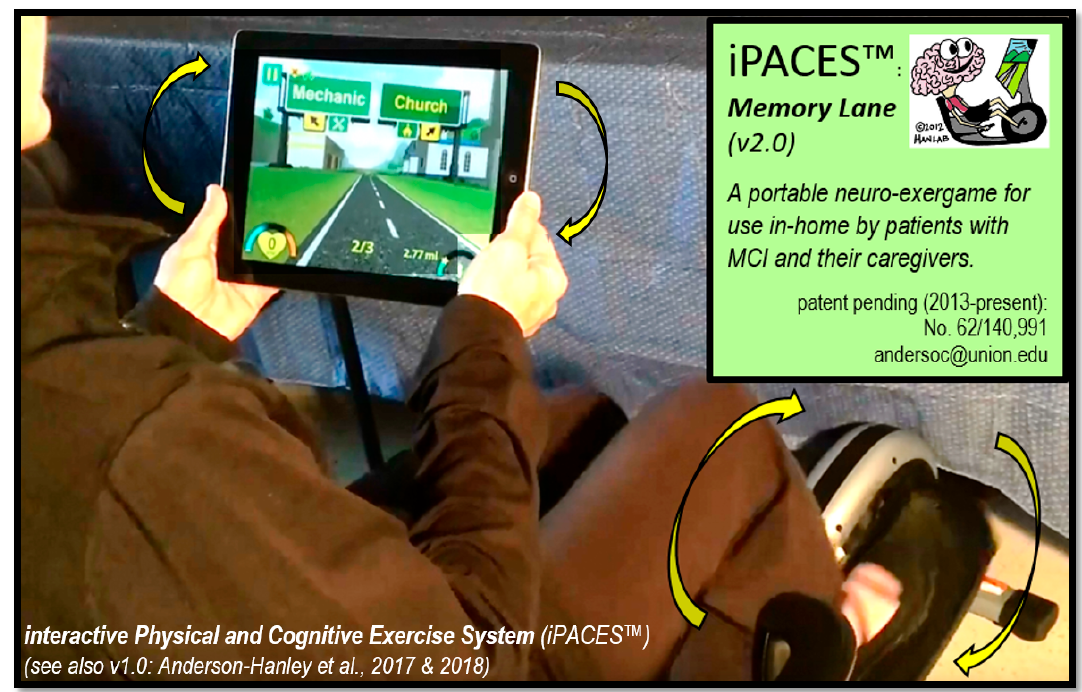
Figure 2. Illustration of the use of interactive pedaling and steering of the iPACES™ v2.0 neuro- Illustration of the use of interactive pedaling and steering of the iPACES™ exergame, Memory Lane.